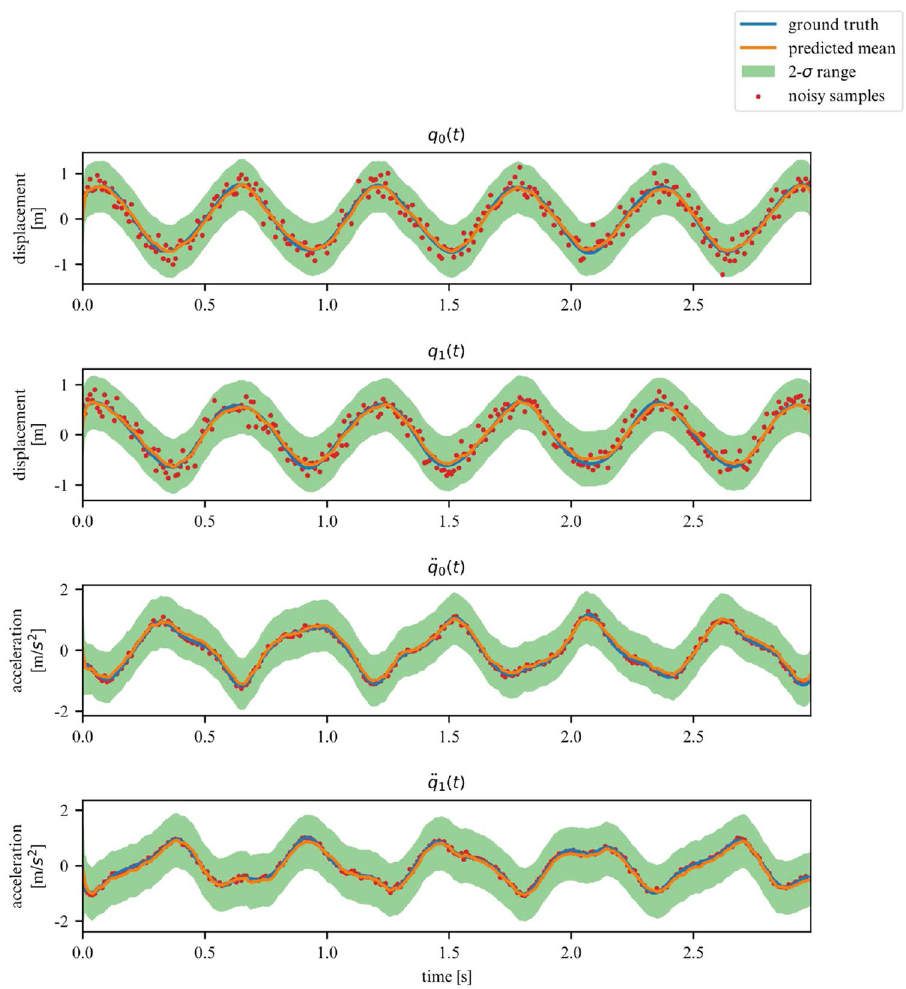
Figure 13. Duffing oscillator observations.